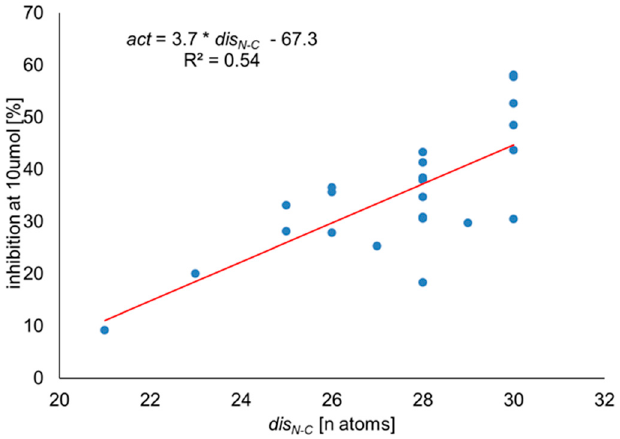
Figure 4. Correlation of inhibitory activity at 10 µ M with the topological distance between guanidine groups at the N- and C-termini of the ligands (Model 1).